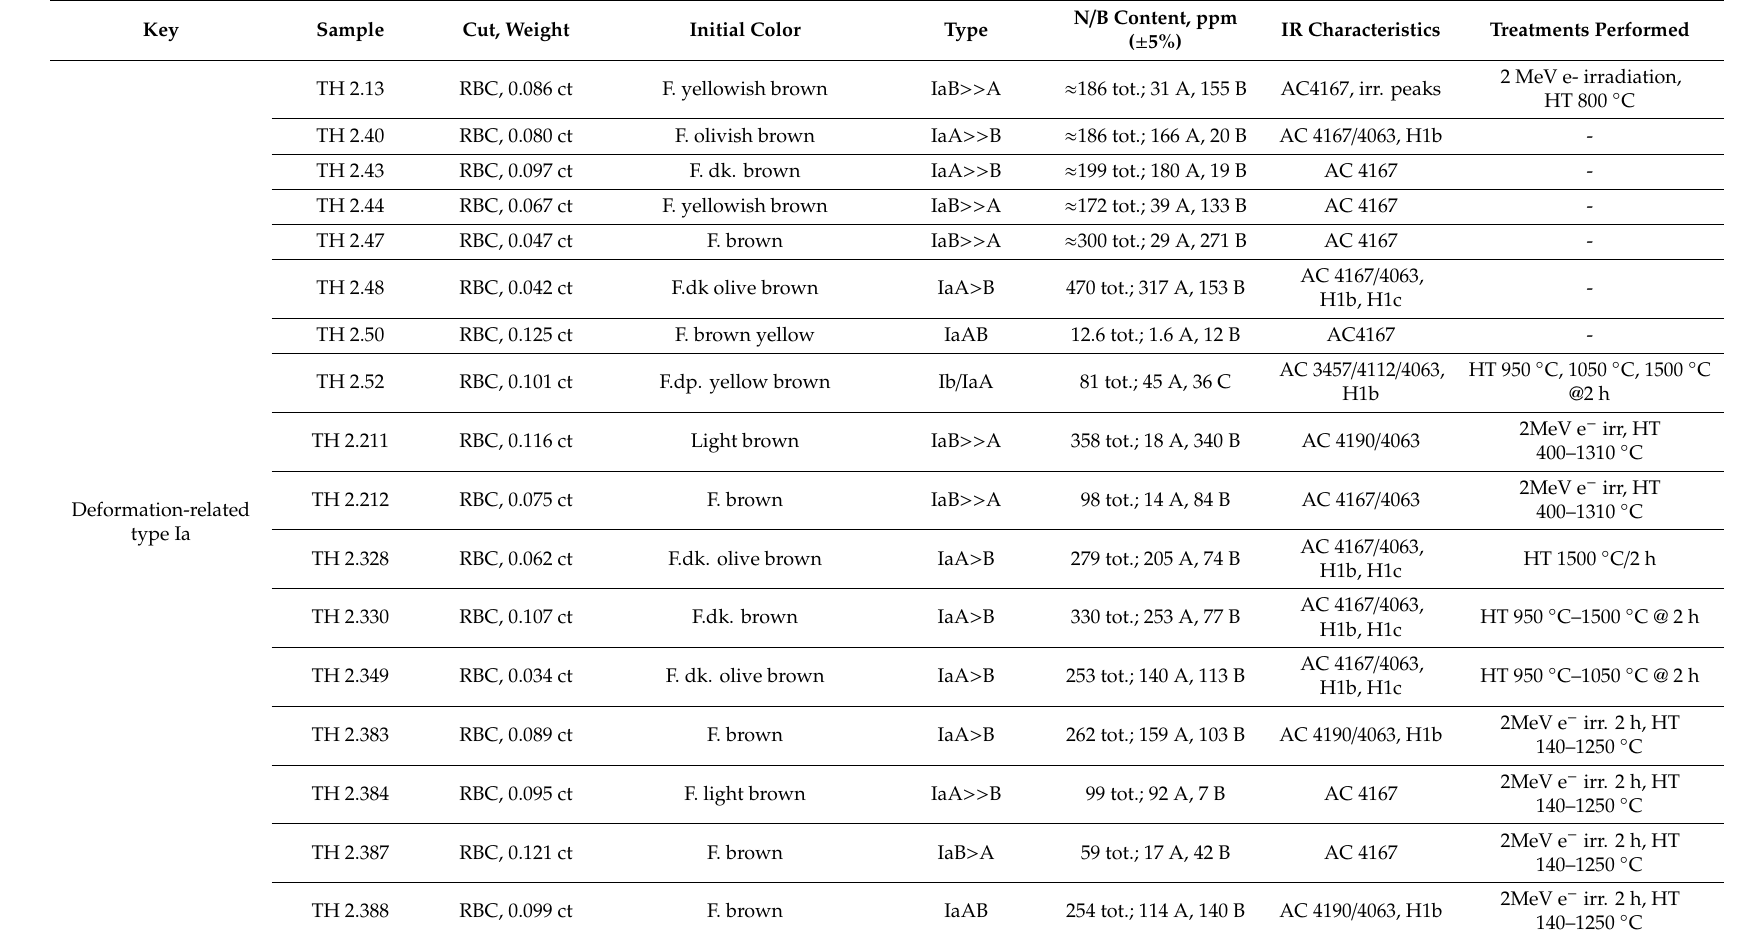
Table 1. An overview of the samples studied with some of their basic optical and infrared spectroscopic